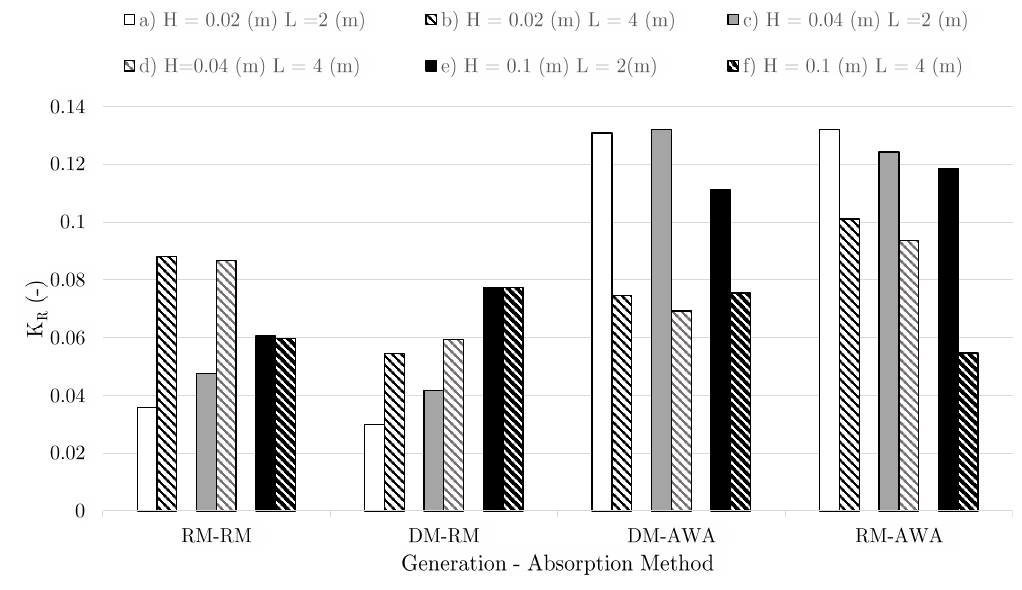
Figure 3. Reflection coefficients for all the different method